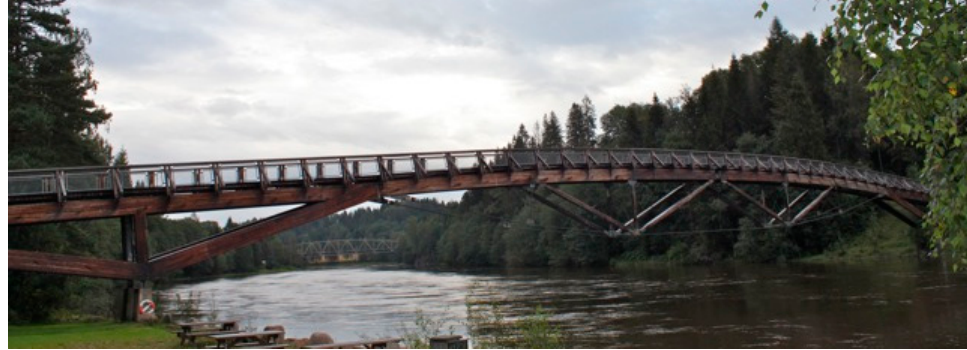
Figure 9. The Lardal footbridge. (Picture after http://broer-vestfold.blogspot.com/2011/08/bro-v-kjrra-fossepark-i-lardal.html.).